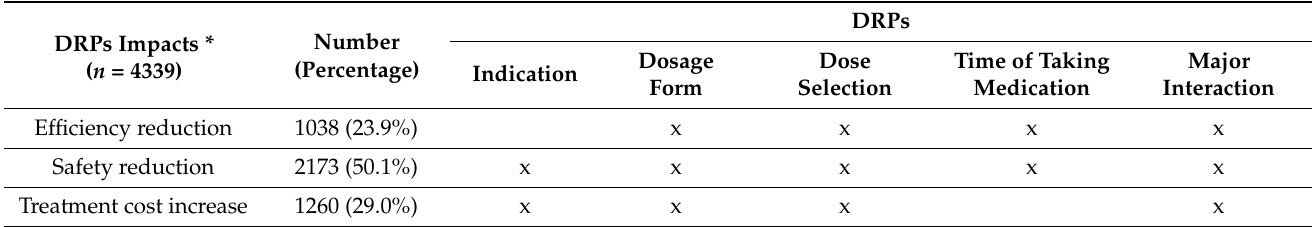
Table 5. Impacts of DRPs on effectiveness, safety, and cost in prescribing.